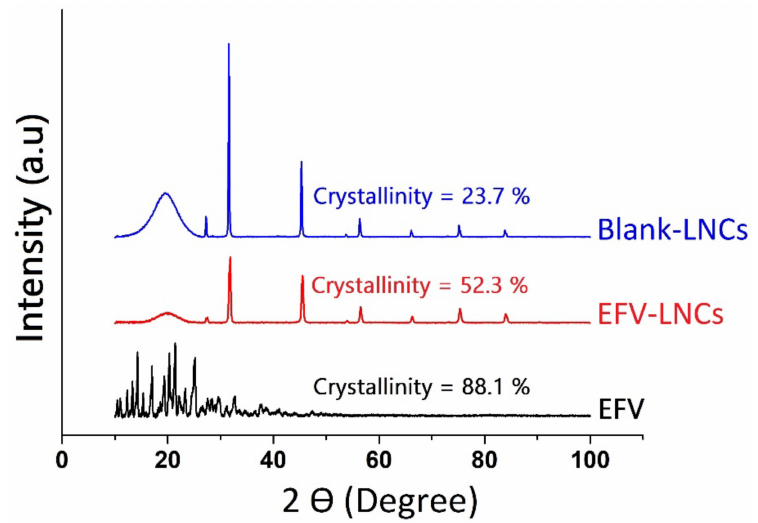
Figure 9. XRD diffractograms of blank-LNC, EFV-LNCs and